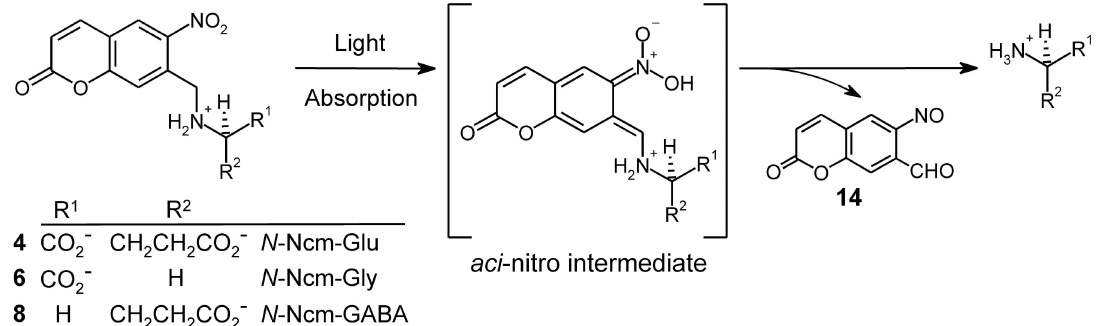
Fig 6. Photolysis of Ncm-cagedamino acids. Light absorptionleads to the transient aci -nitro intermediate, which decomposes into the free amino acid and the spent cage (7-formyl-6-nitrosocoumarin). The caged molecules are depicted as N -protonated species because the pK a s for the α -aminogroups are all estimated to be higher than physiologicpH (details in S3 Text).